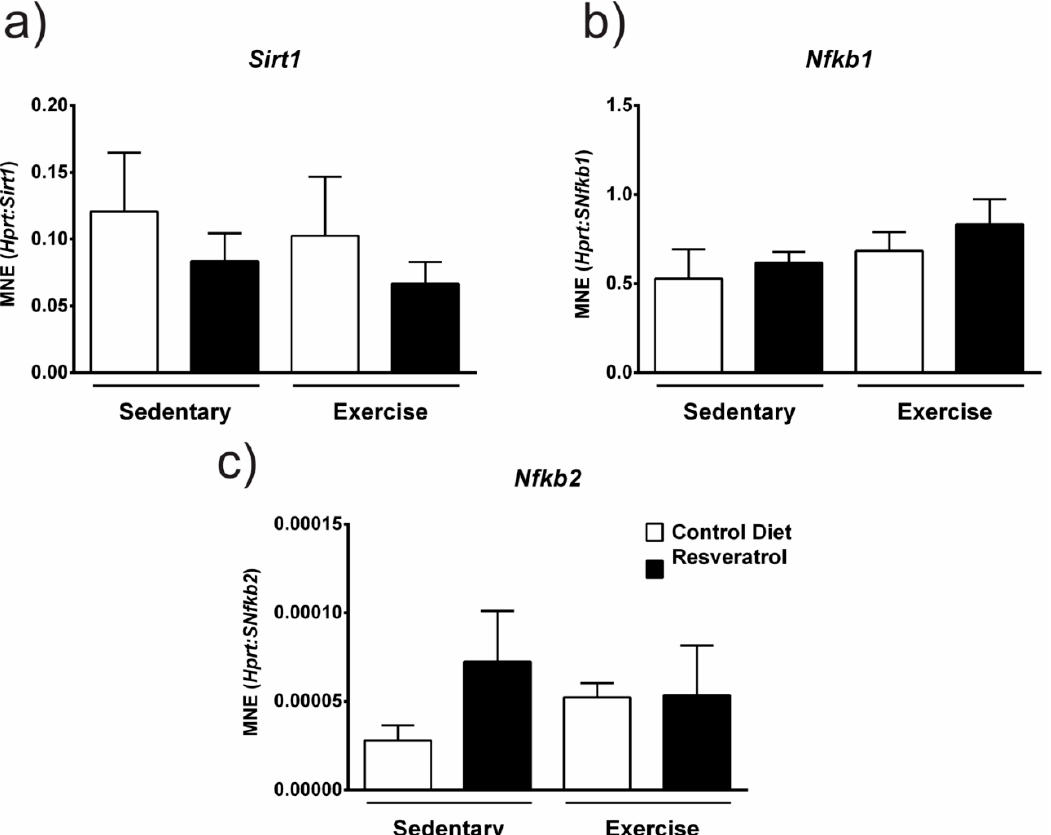
Figure 7. ( a ) Sirt1 gene expression is unchanged with resveratrol treatment in both sedentary and exercise groups when compared to respective controls. ( b ) Gene expression of NF- κ B1 is unchanged with resveratrol treatment in both the seden- tary and exercise cohorts. ( c ) Likewise, NF- κ B2 gene expression is not significantly altered with resveratrol administration in either sedentary or exercised mdx mice. Graphs show mean ± SEM n = 5 per treatment group.